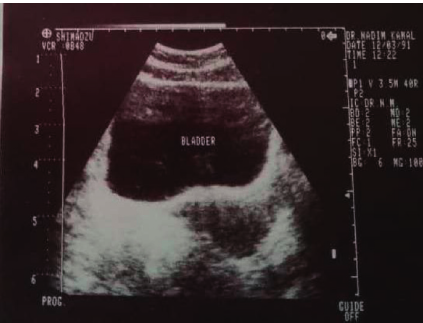
Figure 1: Ultrasound scan of the kidneys, ureters, and bladder showed thickening and irregularity of the bladder wall.